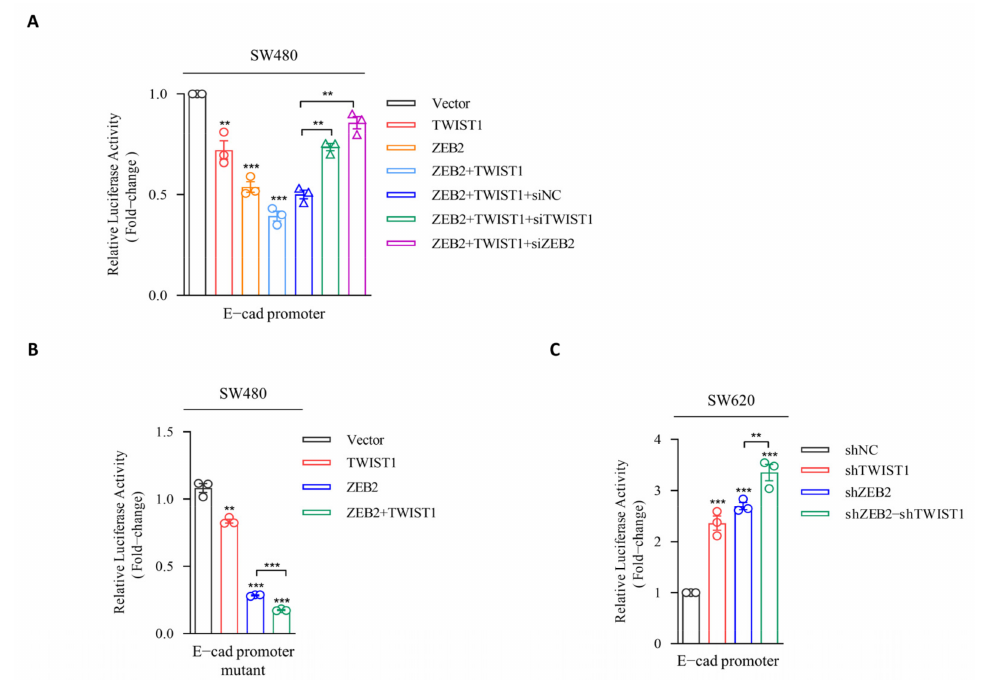
Figure 3. ZEB2 recruits TWIST1 to the E-cadherin promoter to synergistically repress transcription. ( A ) Luciferase reporter plasmid pGL3-E-cadherin promoter-Luc, Renilla (pRL-SV40), TWIST1, ZEB2, TWIST1+ZEB2, TWIST1+ZEB2+siNC, TWIST1+ZEB2+siTWSIT1, and TWIST1+ZEB2+siZEB2 were transfected into SW480 cells, 48 h later, luciferase activity was assayed and normalized to Renilla. ( B ) Plasmid pGL3-E-cadherin promoter mutant-Luc, Renilla, TWIST1, ZEB2, and TWIST1+ZEB2 were transfected into SW480 cells, 48 h later, luciferase activity was assayed and normalized to Renilla. ( C ) SW620 cells (SW620-shNC, SW620-shTWIST1-1, SW620-shZEB2-1, and SW620-shZEB2- shTWIST1) express plasmid pGL3-E-cadherin promoter-Luc. Luciferase activity was assayed and normalized to Renilla. Data points represent the mean ± SD ( n = 3). ** p ≤ 0.01; *** p ≤